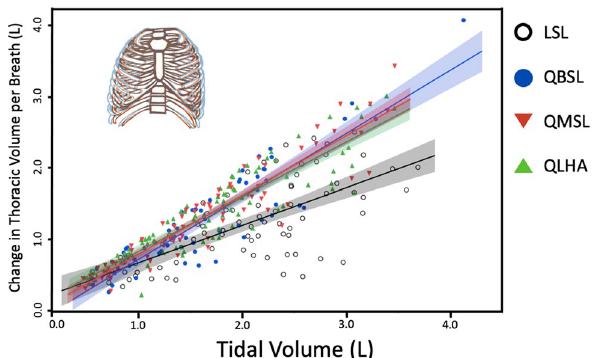
Figure 3. Absolute thoracic expansion and contraction (L) increased with absolute V T (L) significantly more in QLHA (slope ± S. 0.75 ± 0.03, R 2 = 0.81; p = 0.002), QMSL (0.81 ± 0.04, R 2 = 0.87; p < 0.001) and QBSL (0.83 ± 0.06,